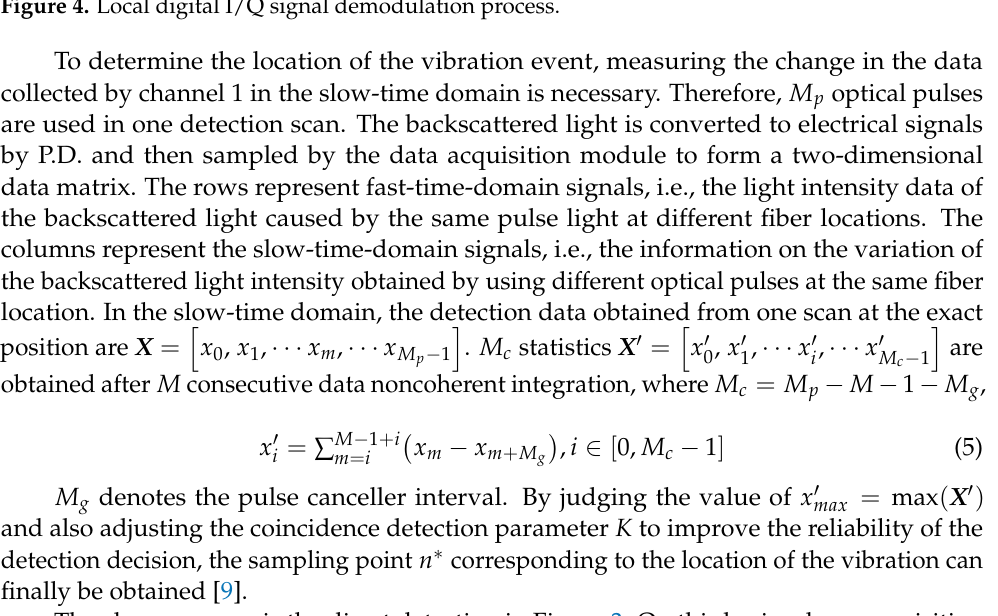
Figure 4. Local digital I/Q signal demodulation process.